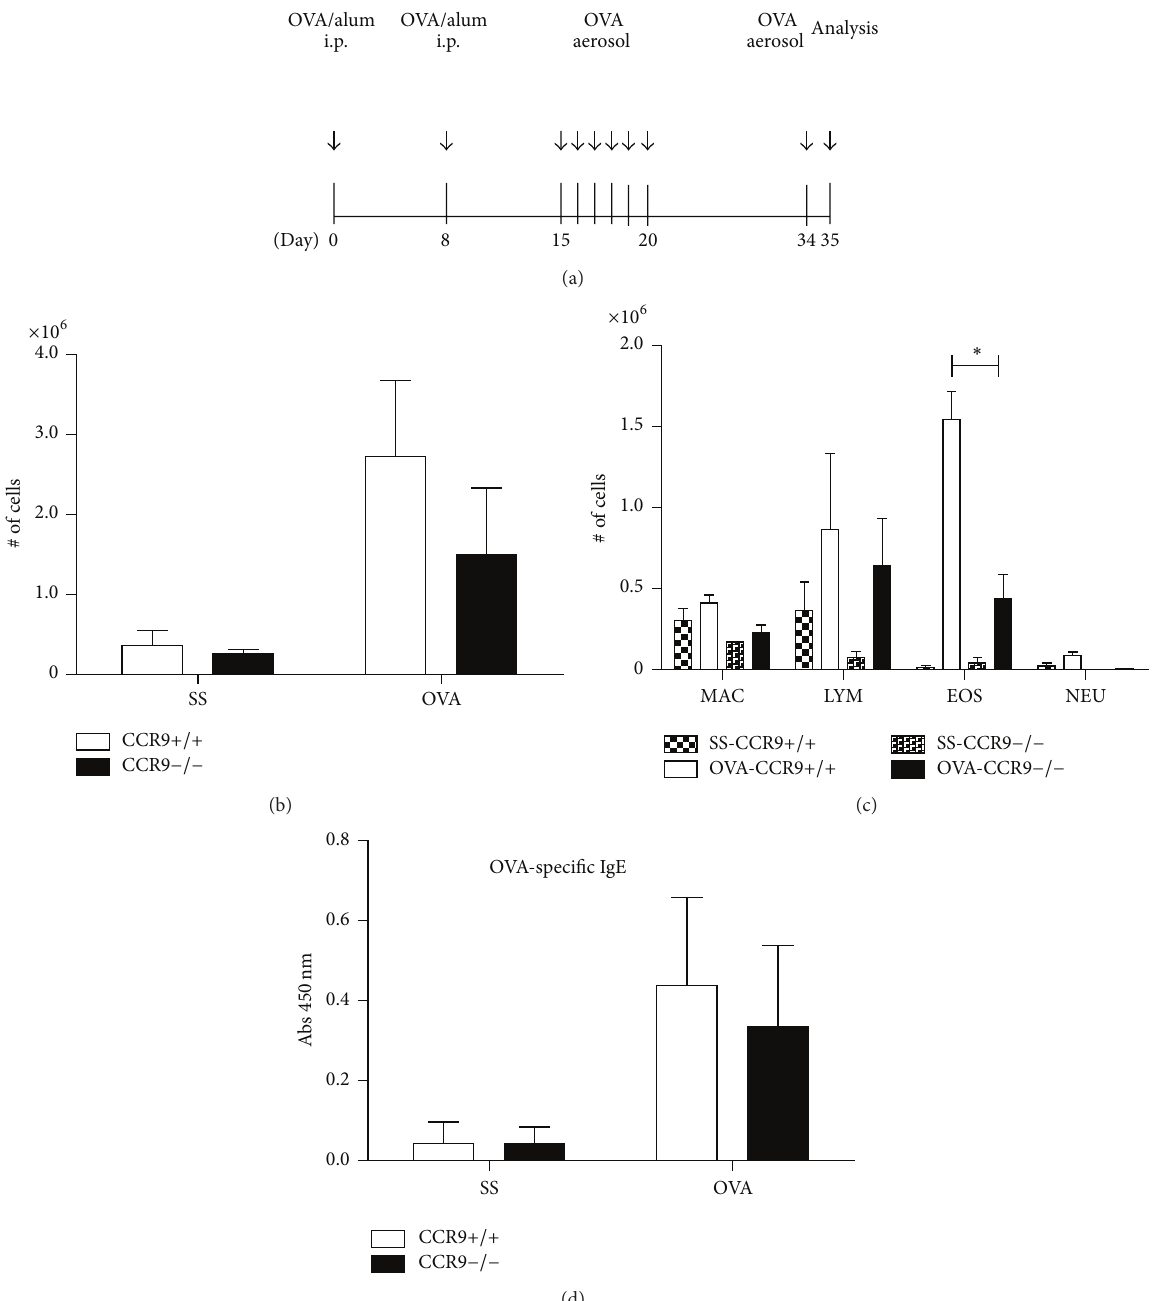
Figure 1: Leukocyte recruitment is impaired in BALF in absence of CCR9. (a) Wild type (WT) and knockout (KO) mice were first sensitized with OVA/alum intraperitoneally. Control animals received saline solution (SS). OVA was aerosolized as indicated. Mice were sacrificed 24 h after the last antigen challenge. (b) Total number of cells from BALF WT and KO mice was quantified. (c) Collected BALF cells were stained with Wright’s stain and lymphocytes (LYM), macrophages (MAC), eosinophils (EOS), and neutrophils (NEU) were distinguished morphologically. (d) OVA-specific IgE was determined by ELISA in serum samples from mice. Data represent mean ± SD and are representative of 4 independent experiments. 𝑛 = 3 -4 for each group ( ∗ 𝑝 < 0.05 when compared with WT group).